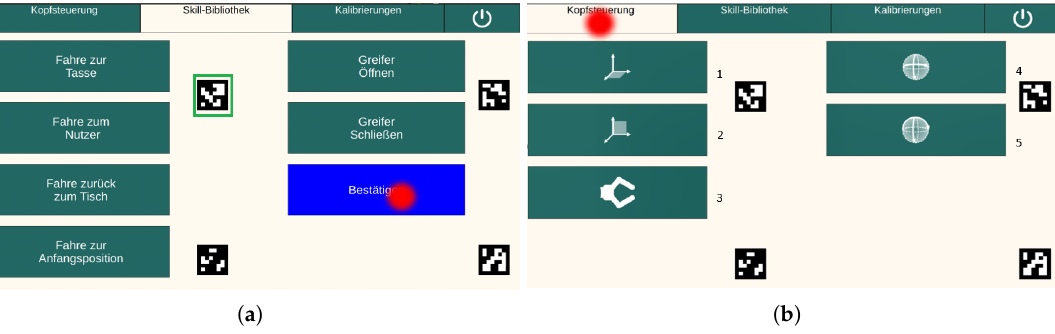
Figure 3. Test 1: ( a ) GUI with the six buttons of the skill library and confirmation button (blue rectangle), green rectangle = aruco marker, red point = cursor controlled by either eye or head movements on the screen; and ( b ) GUI with the five buttons of the head robot control, red point = cursor controlled by either eye or head movements on the screen, 1 = hplane, 2 = vplane, 3 = gripper, 4 = orient1, and 5 = orient2.